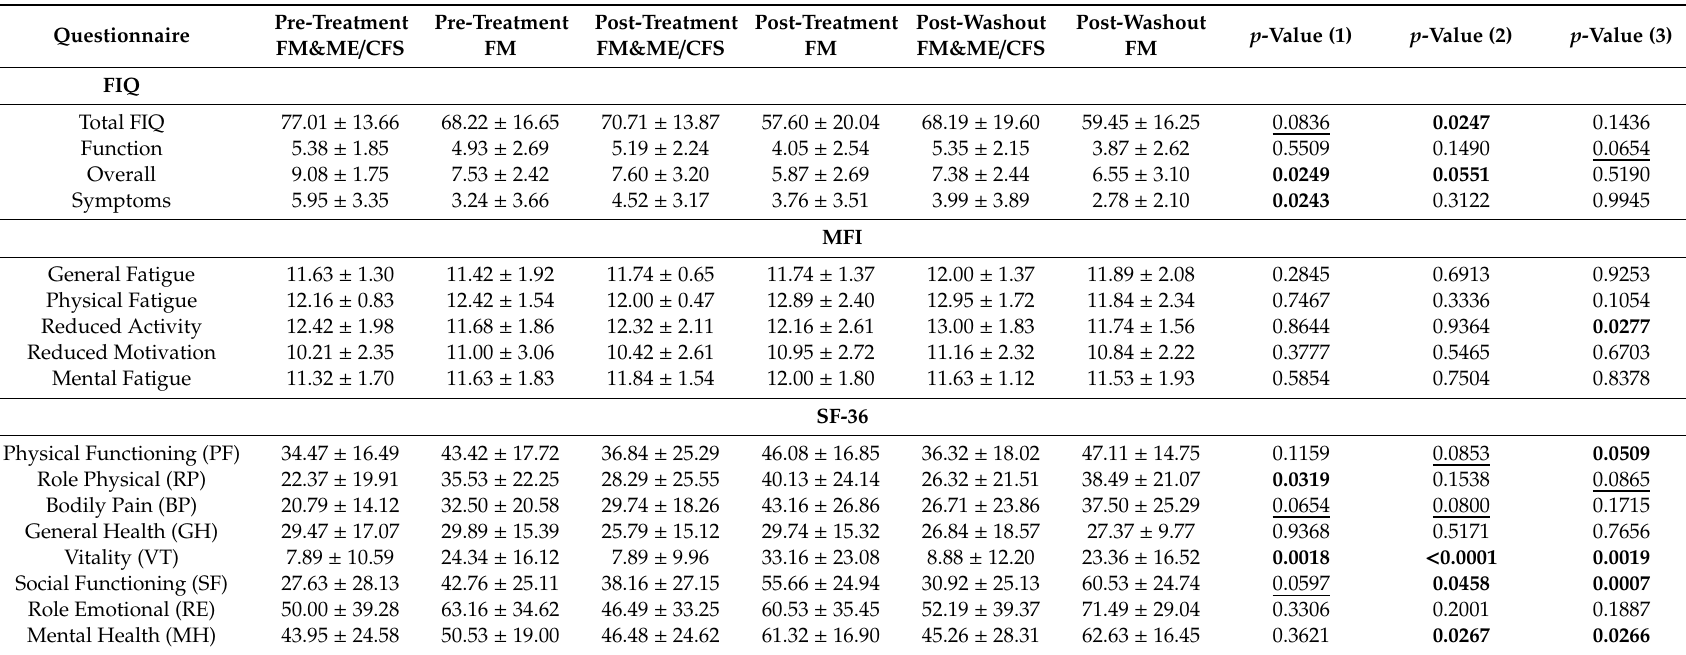
Table 5. Di ff erences between FM patients presenting or not comorbid ME / CFS, assessed by FIQ, MFI and SF-36 instruments